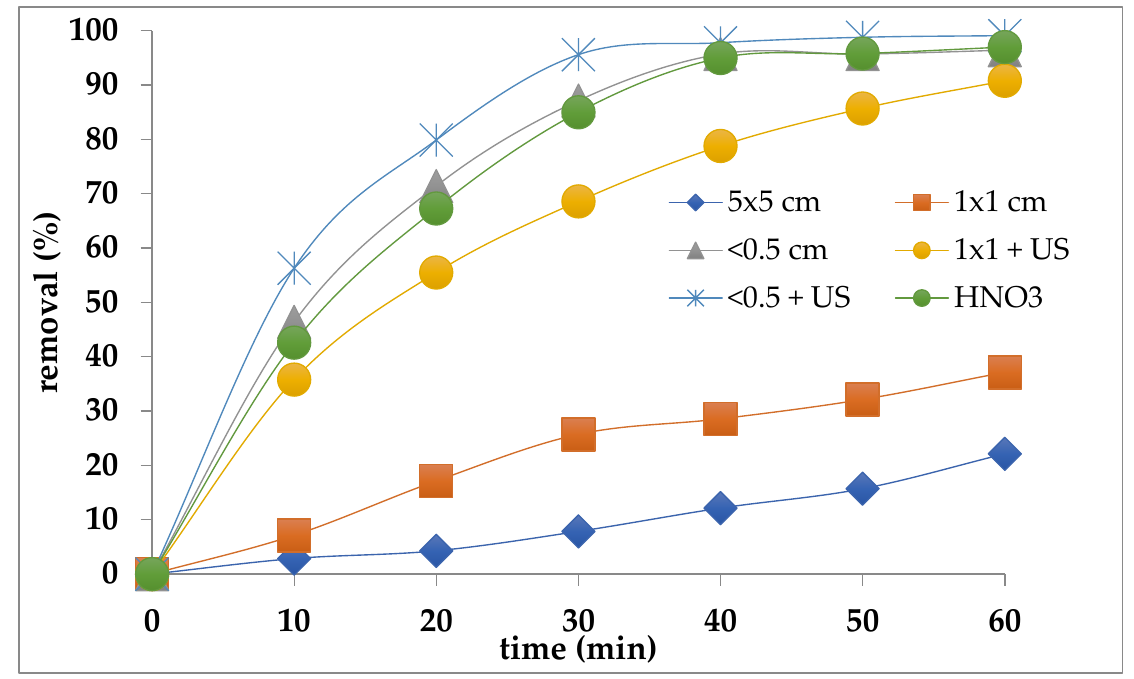
Figure 5. Effect of the sample dimensions on the removal of adherent materials by H 2 O 2 = 40% and HNO 3 (30%, samples < 5 mm). T = 20 °C, US = ultrasound 50 MHz.